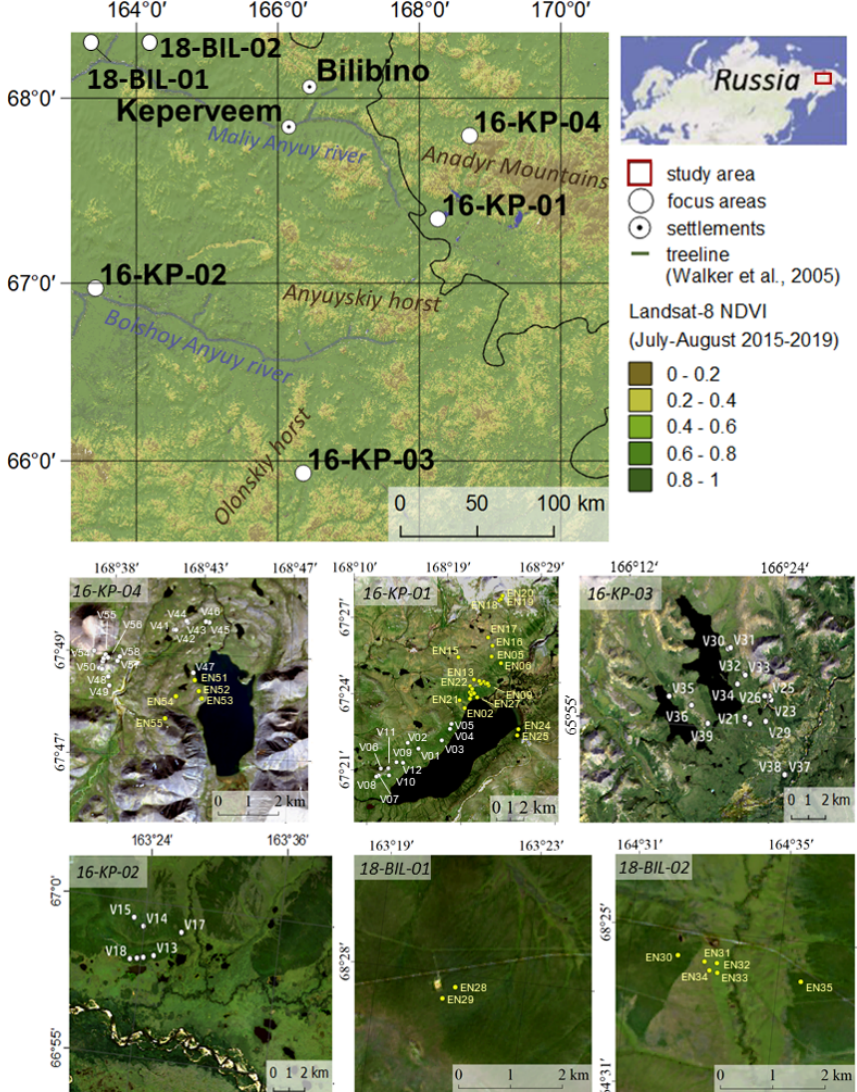
Figure 1. Overview of the study region and four focus areas – tundra (16-KP-04), northern tundra–taiga (16-KP-01), southern tundra–taiga (16-KP-03), and northern taiga (16-KP-02) – and two areas with supplementary AGB sampling – 18-BIL-01 and 18-BIL-02 (tundra–taiga to northern taiga). Sample plot names of the 2016 expedition are V01–V58, sample plot names of the 2018 expedition are EN01–EN55 (abbreviated here to EN# rather than EN18#). Overview map modified from Shevtsova et al. (2020a). Base maps of study areas are Landsat 8 RGB composites. Black colour represents no data or